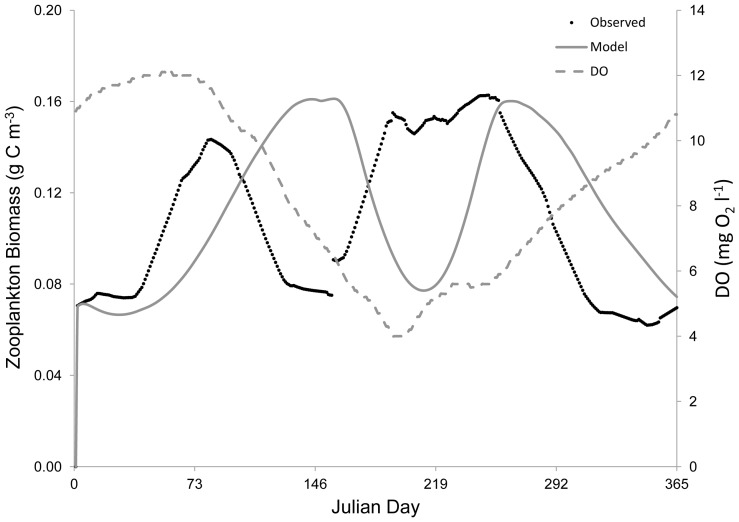
Verification of the macrobenthos state variable during hypoxia.Left y-axis: the gray solid line represents modeled macrobenthos biomass and the black dots denote observed macrobenthos biomass from site LE3.2 of the Chesapeake Bay Benthic Monitoring Program in 1992. Right y-axis: the grey dashed line indicates the dissolved oxygen concentration. Modeled macrobenthos biomass matched the trends and magnitude of observed macrobenthos biomass in 1992.